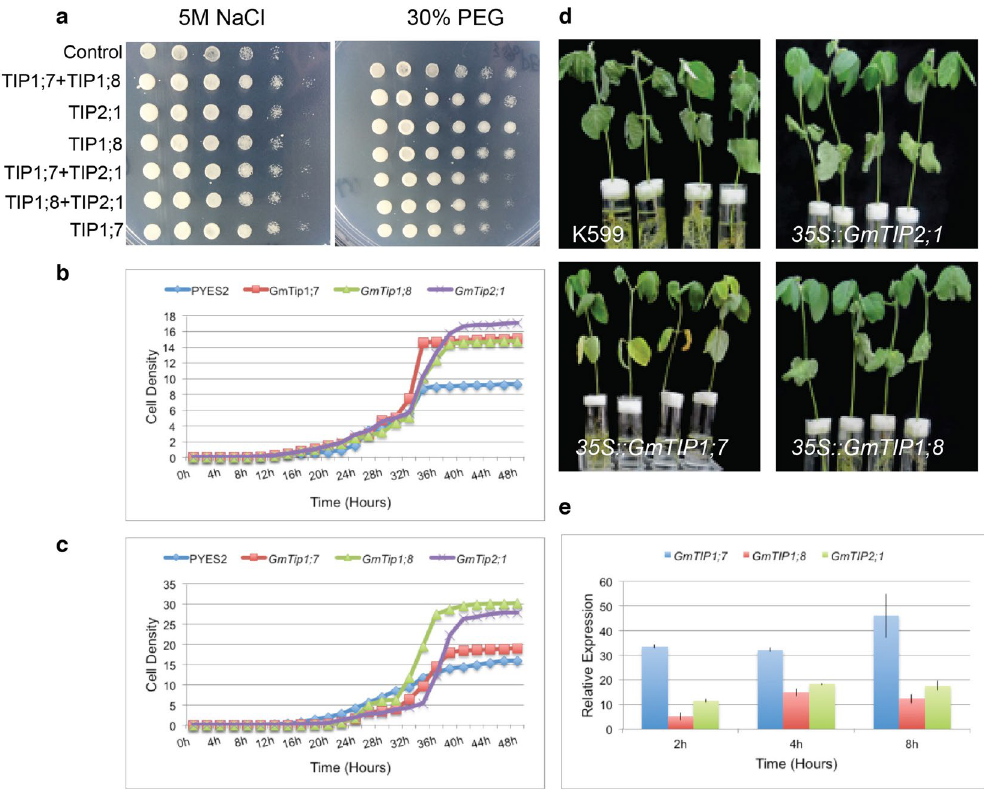
Figure 6. Overexpression of GmTIP2;1 , GmTIP1;7 and GmTIP1;8 improved salt and drought tolerance in Saccharomyces cerevisiae and soybean. ( a ) Various combination of overexpressing yeast cells were plated on 30% PEG 6000 and 5 M NaCl into SC-Ura medium. According to the survival patterns of the yeast cells, it is visible that overexpression of GmTIP2;1 improved salt and drought tolerance in Saccharomyces cerevisiae . ( b , c ) Growth curves depict analysis of the growth of yeast strains overexpressing the indicated proteins in YPDA medium supplemented with NaCl (0.5 M) and PEG (10%). X-axis shows time and Y-axis shows OD600 values. OD were measured every 2 h. ( d ) Phenotypic analysis of the hairy root transformed transgenic plants treated by 200 mM NaCl solution for seven days. The photograph was documented after 7 days of growth of these respective seedlings in hydroponic media containing 200 mM NaCl. (e) Real-time RT-PCR analysis of GmTIP2;1 , GmTIP1;7 and GmTIP1;8 under drought stress: cultivated soybean seedlings were treated with 30% PEG 6000 for 0, 2, 4 and 8 h (P0–8) and relative expression of GmTIP2;1 , GmTIP1;7 and GmTIP1;8 were plotted compared to